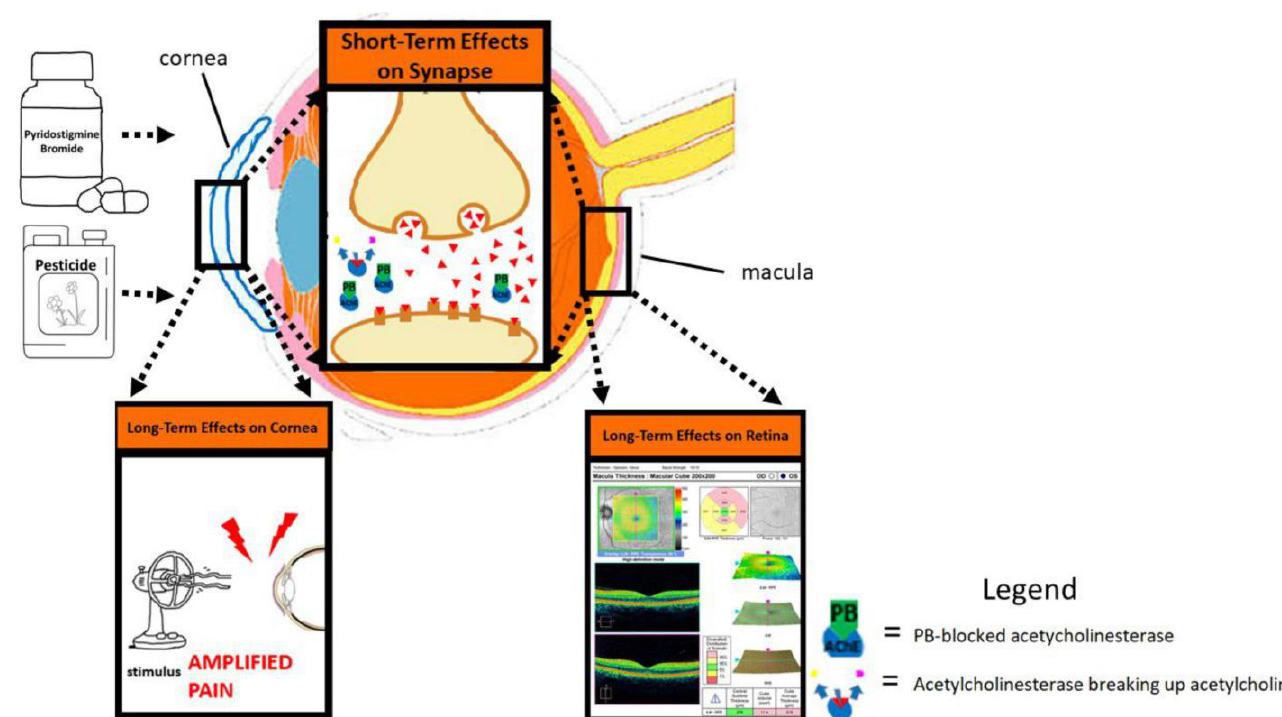
Figure 1. Visual summary of the possible effects of PB pills and pesticides on the cornea and ret-